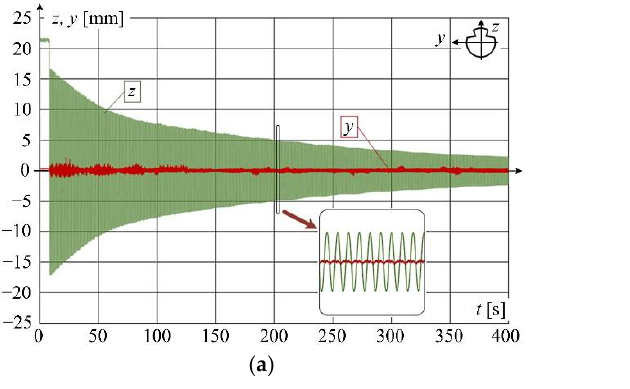
Figure 4. Vibrations of contact wire along z – and y – axes at 10 kN tension ( z – green colour; y – red colour), for step change of vertical force of 150 N at 1 / 4 of the 12-m contact wire span and vibration recording at 1 / 2 of wire span: ( a ) brand-new wire; ( b ) wire with a 15% wear